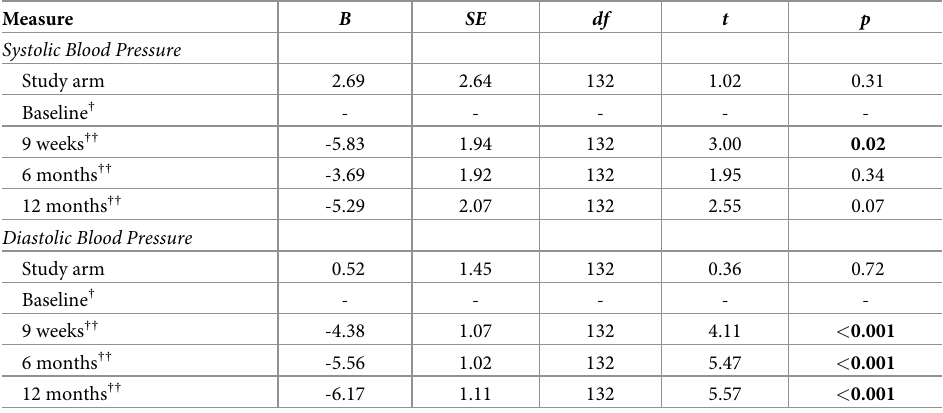
Table 2. Mixed effects regression models: Systolic and diastolic blood